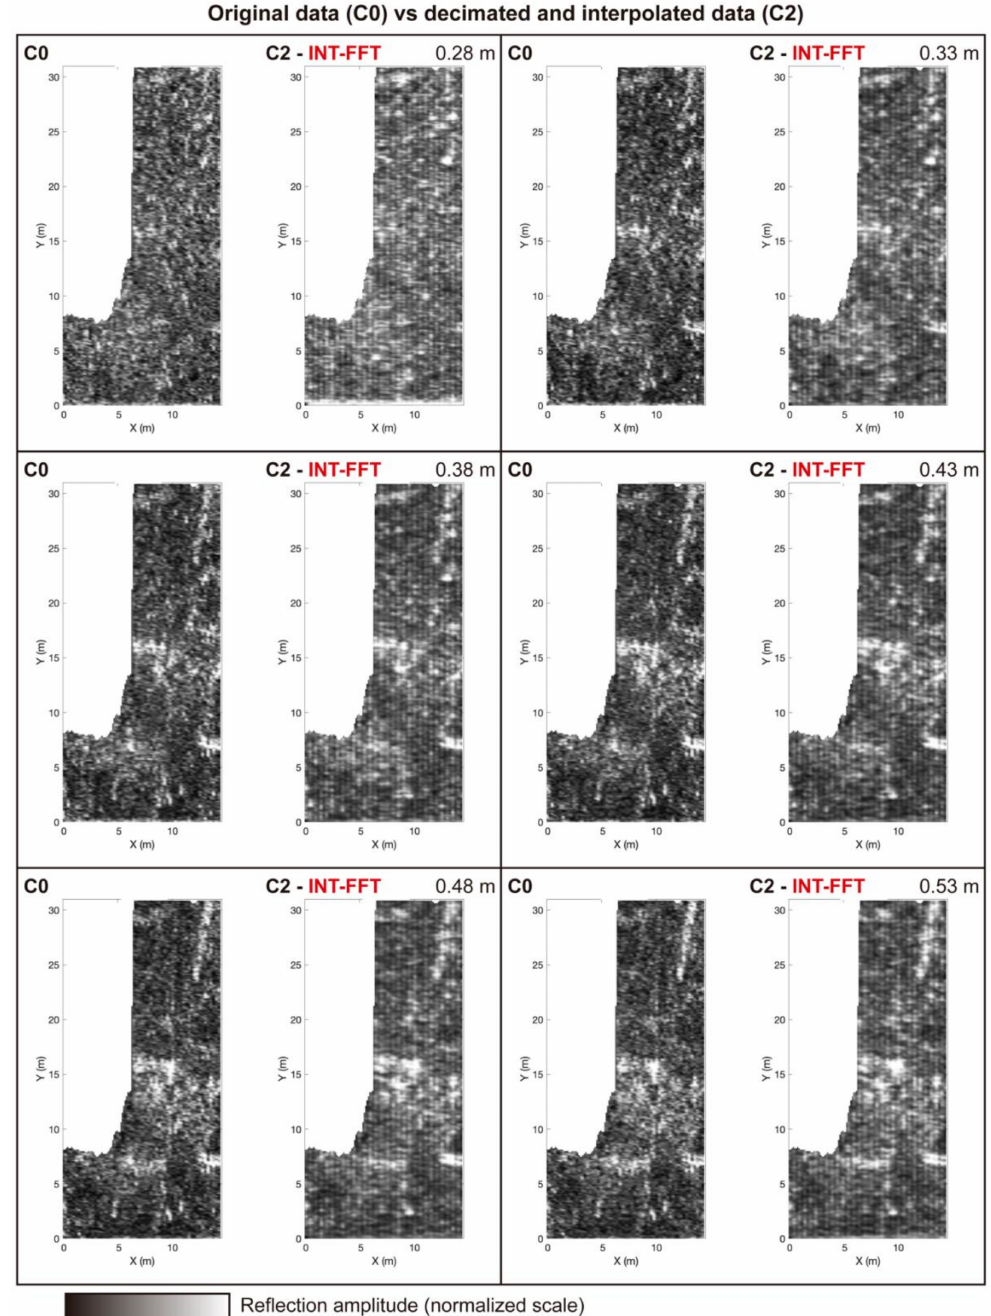
Figure 8. Differences between the original data (C0—d = 0.250 m) and the decimated and interpo- lated data (C2—d = 0.250 m). Data estimation after decimation and interpolation is not complete. Interpolation highlights a striped effect caused by the